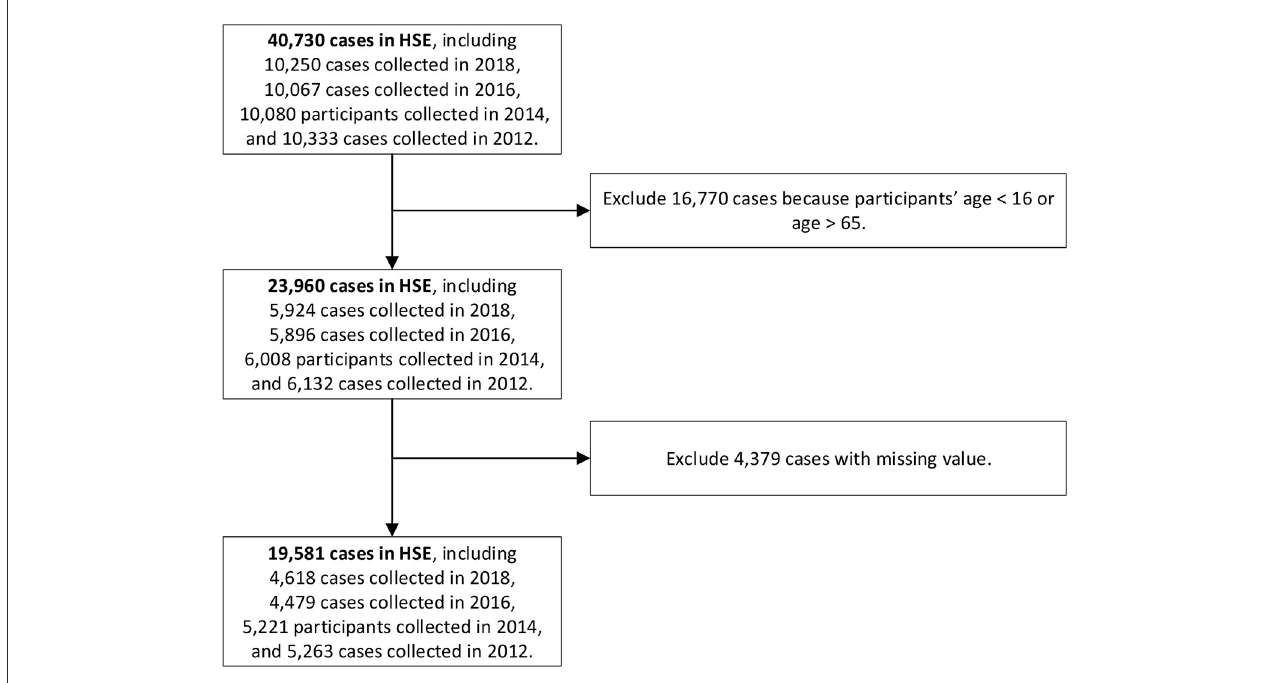
FIGURE1 Inclusion and exclusion of the participants. HSE, Health Survey for